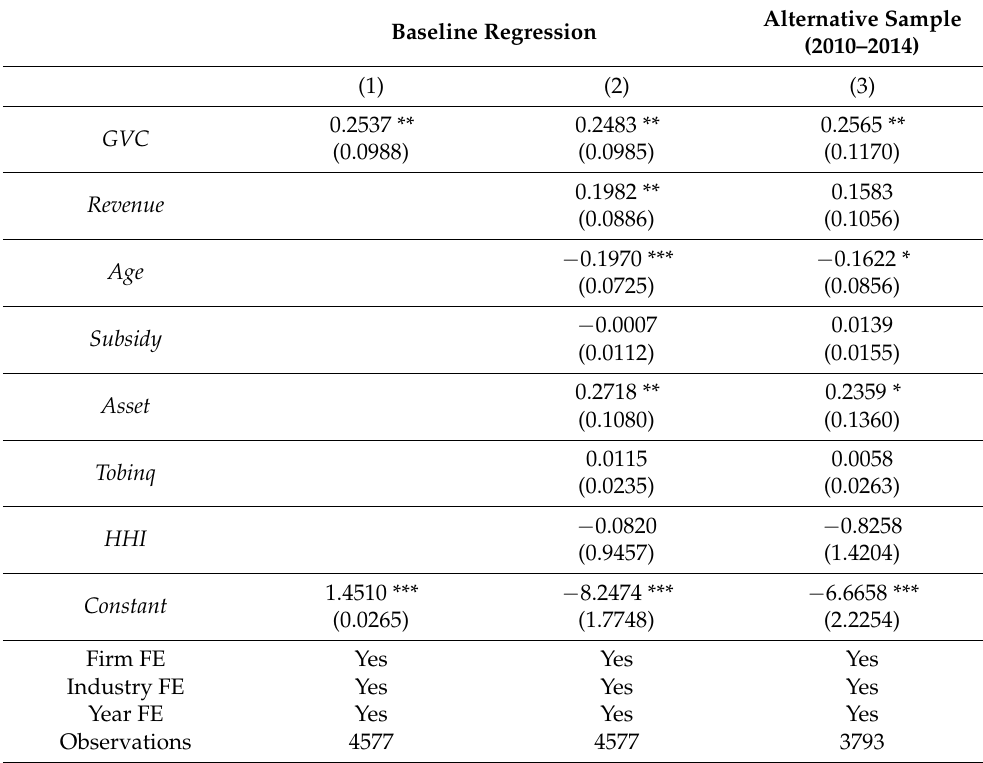
Table 2. Baseline regression and robust checks I.